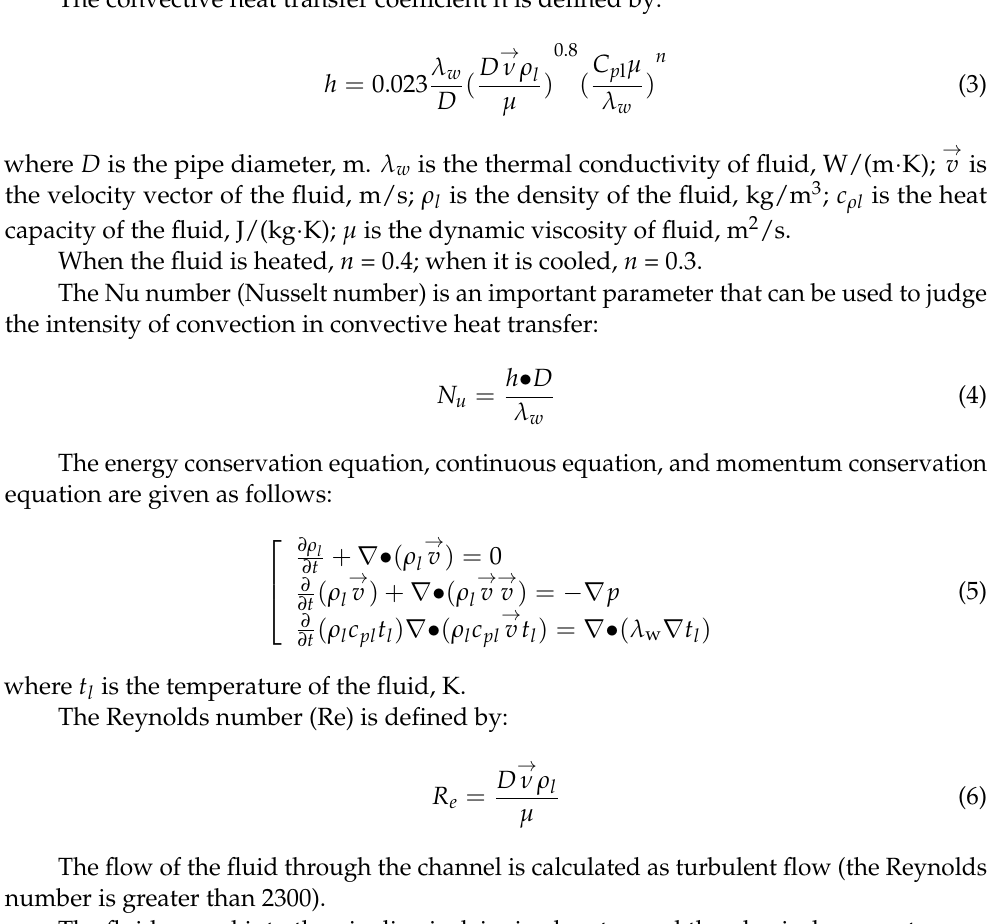
Table 4. Fluid parameters.